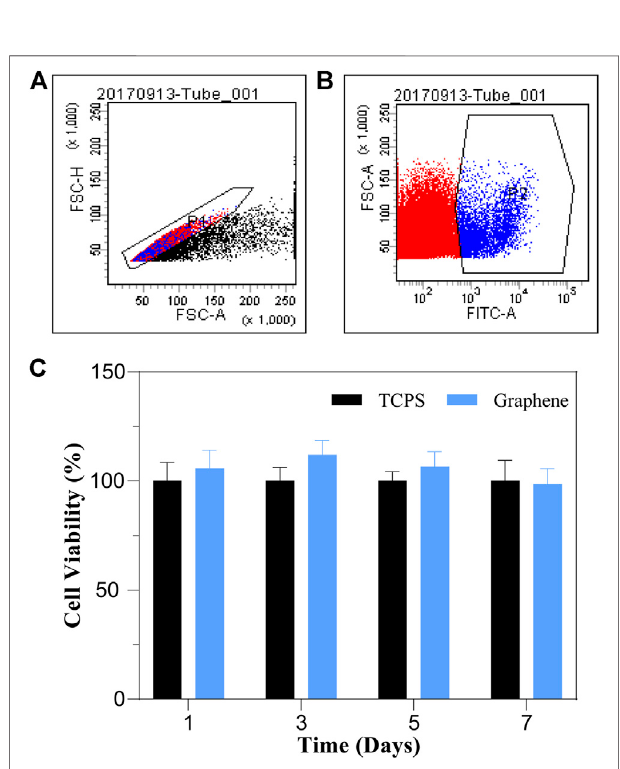
FIGURE 2| FAC sorting plots and the effects ofgraphene substrates on the cell viability of Lgr5+ progenitors. (A,B) FAC sorting plots. (C) Cell viability results from CCK-8